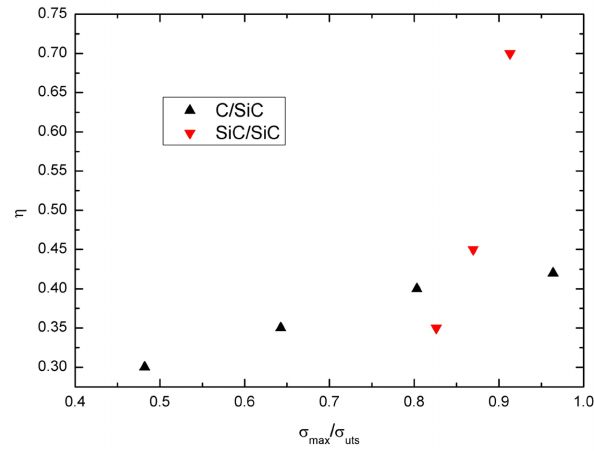
Figure 10. The damage parameter η vs. normalized stress σ max / σ uts curves of cross-ply C/SiC and SiC/SiC